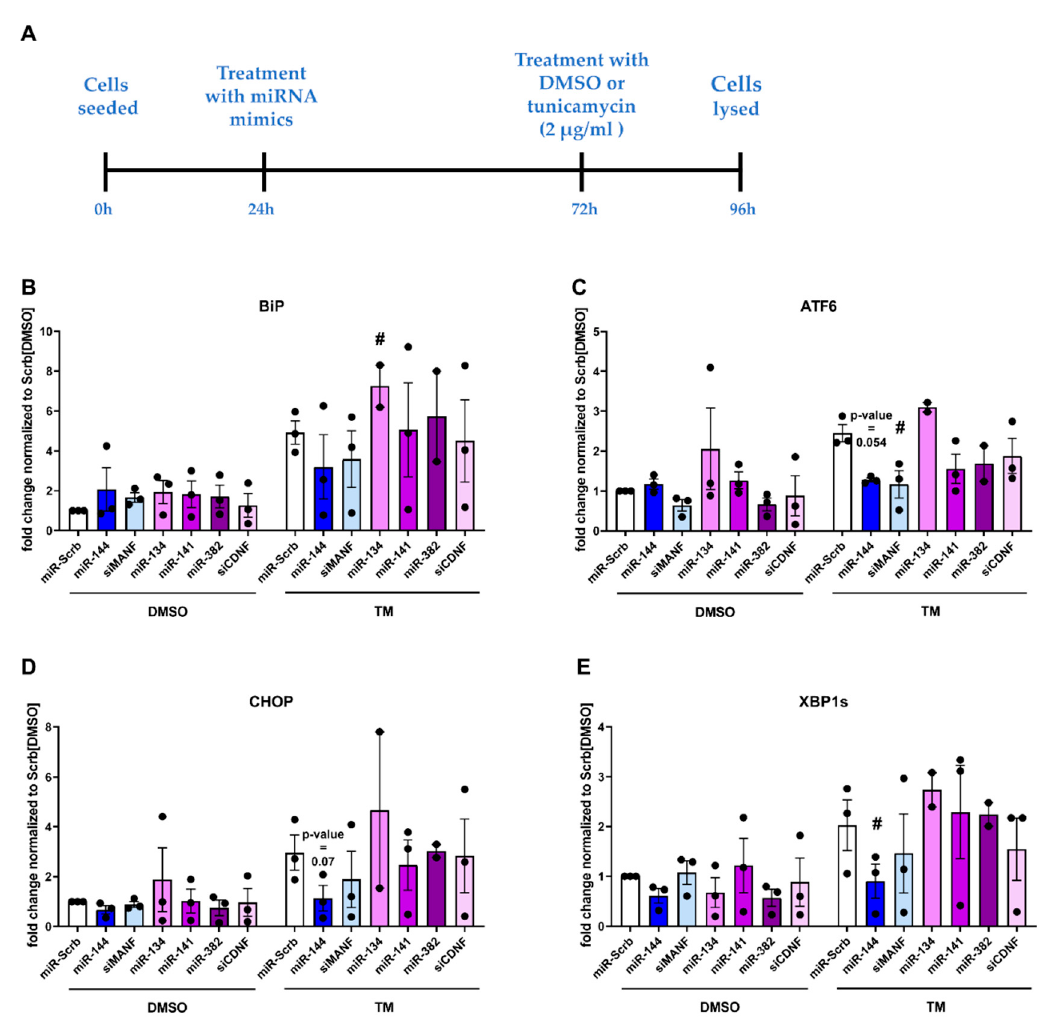
Figure 6. Expression of ER stress markers in HEK293T cells after treatment with miRNAs and DMSO or 2 µg/mL tunicamycin (TM) for 24 h. ( A ) Experiment timeline; Relative expression of BiP ( B ), ATF6 ( C ), CHOP ( D ) and XBP1s ( E ) mRNA. Each dot represents independent biological repeat. # — p -value < 0.05.